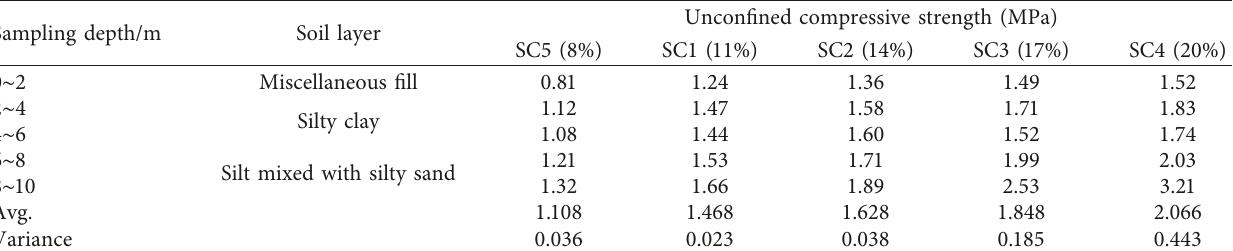
Table 3: Unconfined compressive strength of cement